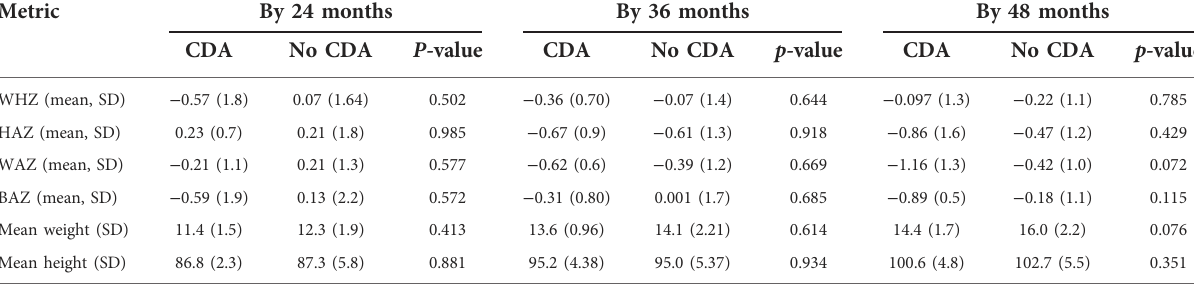
TABLE 3 Anthropometrics of children with and without CDA by age. Metric By 24 months By 36 months By 48